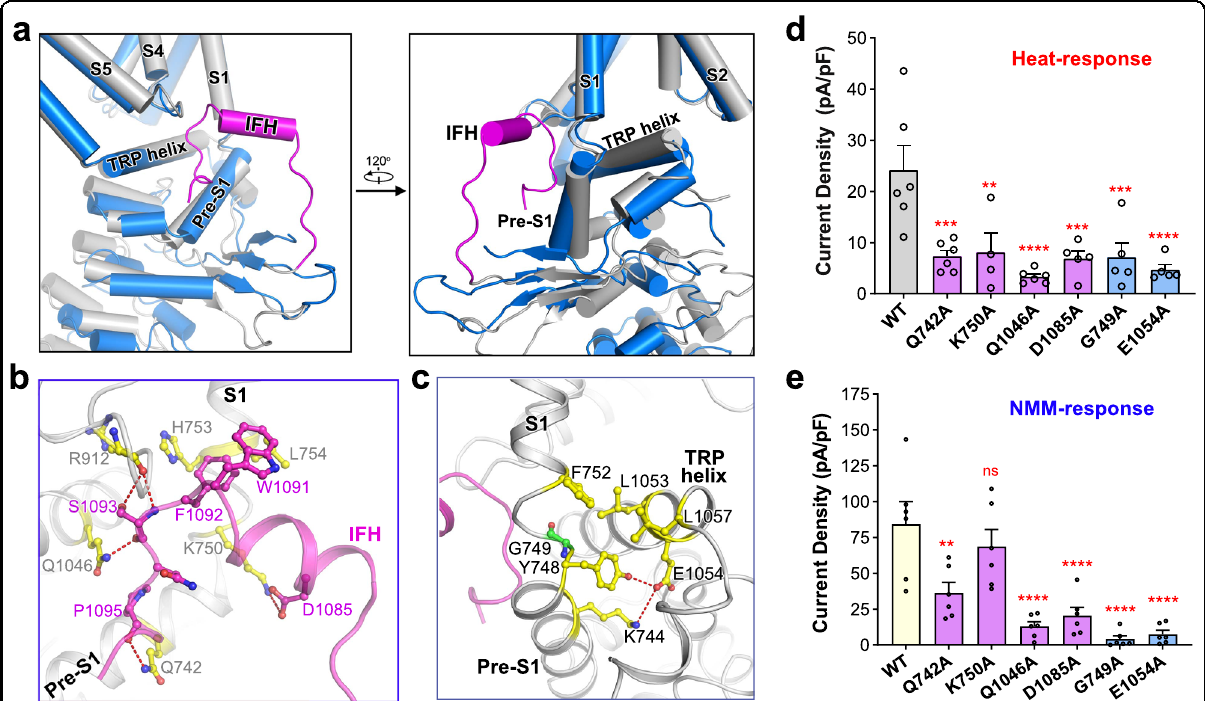
Fig. 3 IFH is stabilised in the state-1 structure of the dTRPA1-A isoform. a Zoomed views of the structure alignment between monomeric dTRPA1-A in two states. Monomers from state-1 and state-2 are coloured grey and marine blue, respectively. The IFH observed in state-1 is shown in magenta. b Zoomed views of the IFH and the IFH-loop. c Interactions between the pre-S1, S1 and TRP helices. Side chains of the surrounding structure are coloured by atom type, with carbon shown in yellow. Hydrogen bonds are indicated by red dashed lines. d Heat-induced current densities for WT dTRPA1-A and the IFH mutants. Independent experiments were repeated for at least four times for each construct ( n = 6 for all, except K750A where n = 4; and D1085A, G749A and E1054A where n = 5). ** P = 0.002, *** P < 0.0005, and **** P < 0.0001 for WT versus mutants (one- way ANOVA with Dunnett ’ s multiple comparisons test). Data are mean ± s.e.m. e NMM-induced current densities at − 60 mV for WT dTRPA1-A and the IFH mutants. Independent experiments were repeated six times for each construct ( n = 6 for all). ns not signi fi cant, ** P = 0.0016, and **** P < 0.0001 for WT versus mutants (one-way ANOVA with Dunnett ’ s multiple comparisons test). Data are mean ± Fig. S6d, e and Table S2). Expression of the mutants in cells were comparable to the WT channel as examined by western blot, suggesting that the impaired responses of the mutants were not due to changes in the protein level (Supplementary Fig. S7). These results con fi rm that the IFH helix and IFH-loop are essential for the thermal activation of dTRPA1-A. The pivot-forming residue of pre-S1 rotating, G749 of dTRPA1, is conserved in hTRPA1. Notably, the G749A mutant had much impaired